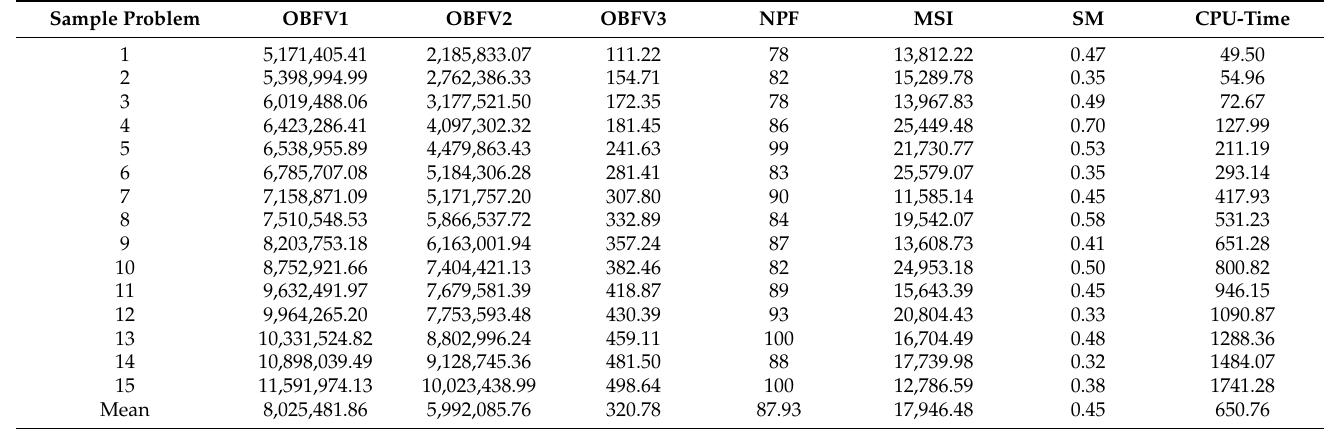
Table 12. The results of solving the large-size problem by NSGA II.